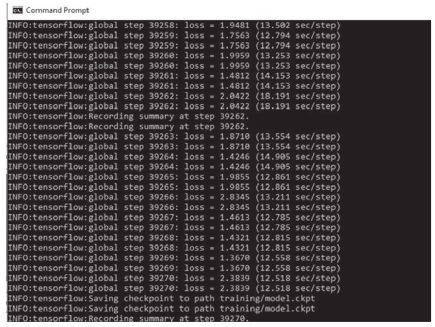
Figure 15: Simulation scenario finishes for 40000